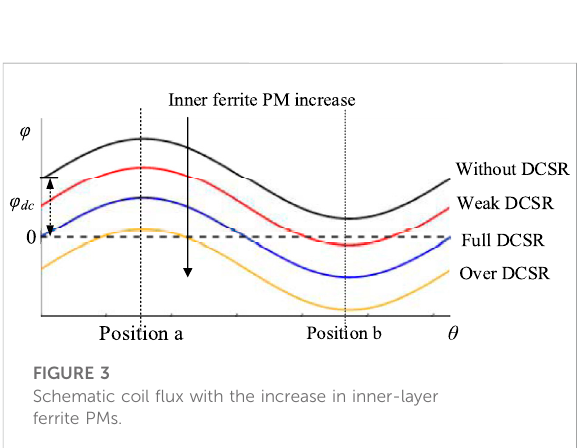
FIGURE 4 Winding con fi guration. (A) 12/10 and 12/14. (B) 12/11 and